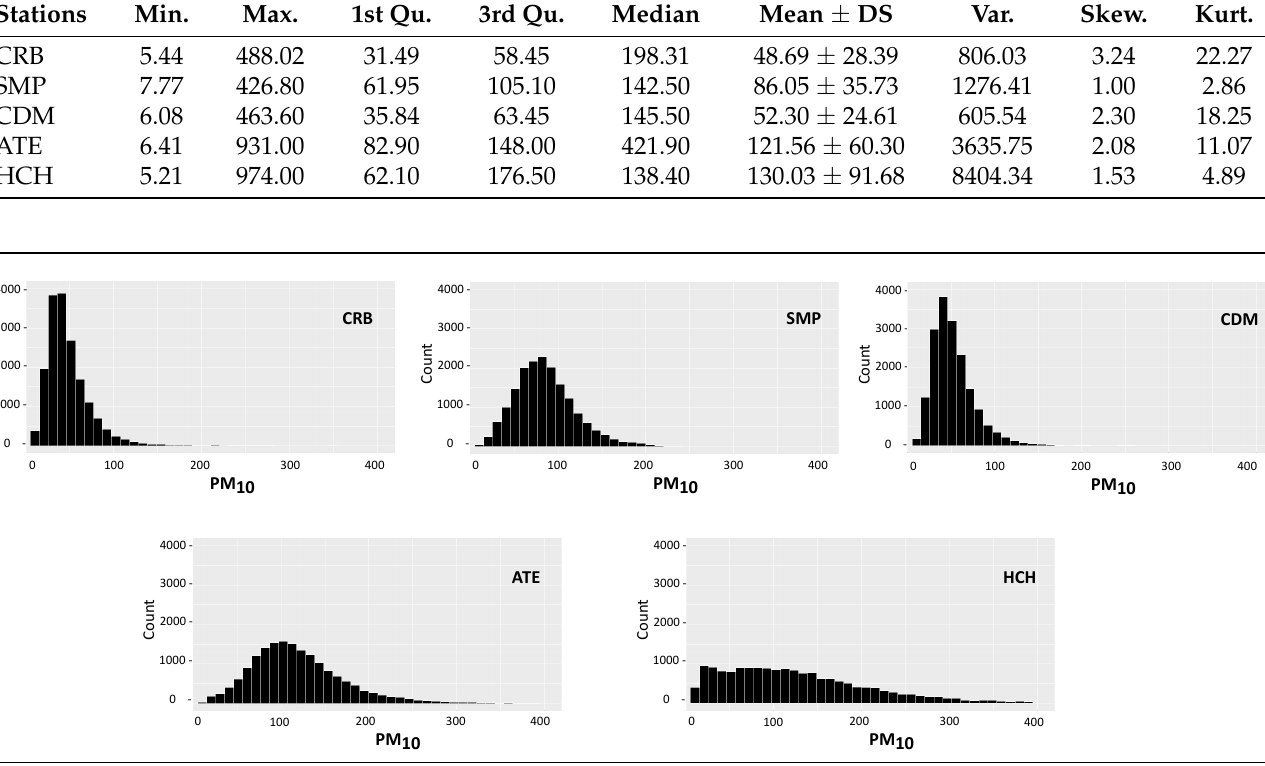
Figure 3. Histogram of PM 10 for each station. The stations with the highest skewness are CRB, CDM and ATE, showing an heavy tail towards the right with respect to the mean of PM 10 .